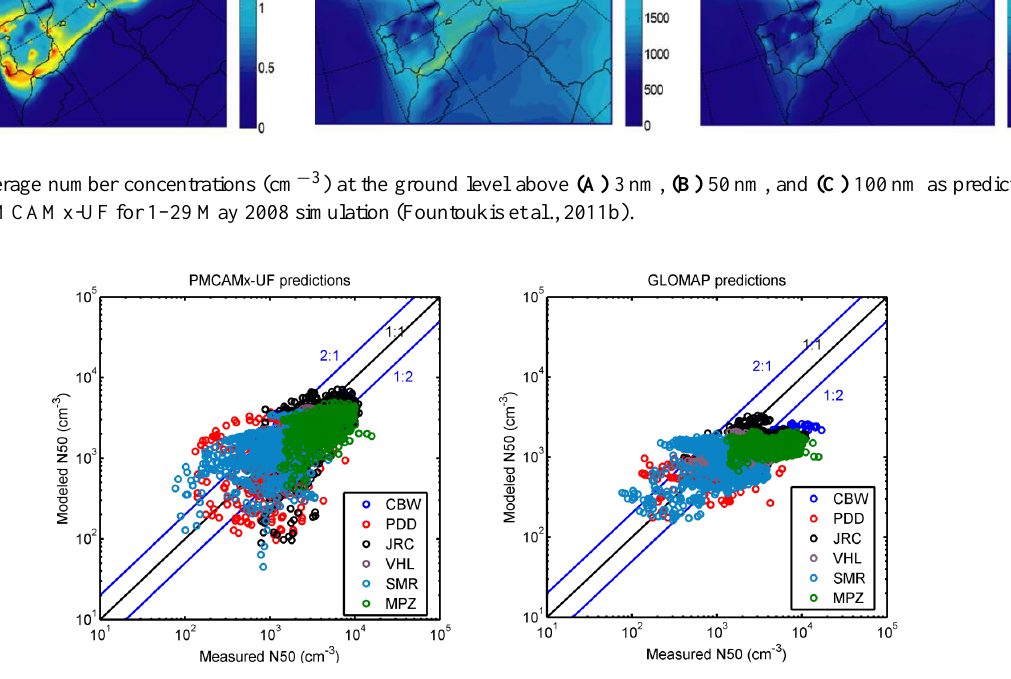
Fig. 16. Comparison of measured and modeled (PMCAMx-UF, left; GLOMAP, right) number concentrations of particles larger than 50nm during May 2008 in a selection of EUCAARI field stations (see Fig. 3 for explanations of the letter codes for the stations). The model runs have been conducted using the nucleation parametrisations and primary aerosol emission inventories developed in